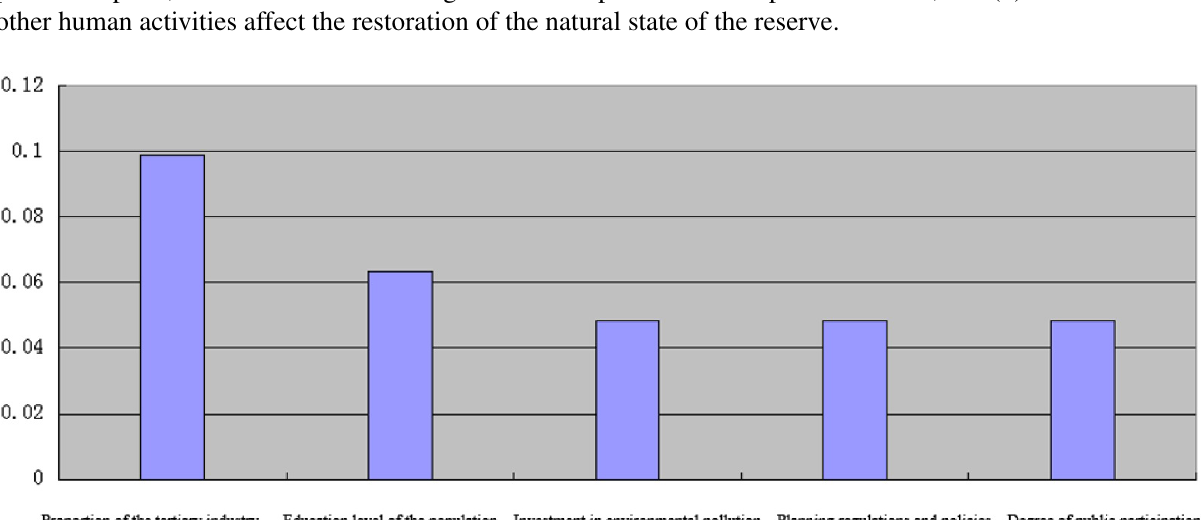
Fig. 6 Comparison diagram of weighted scores of each index in the response